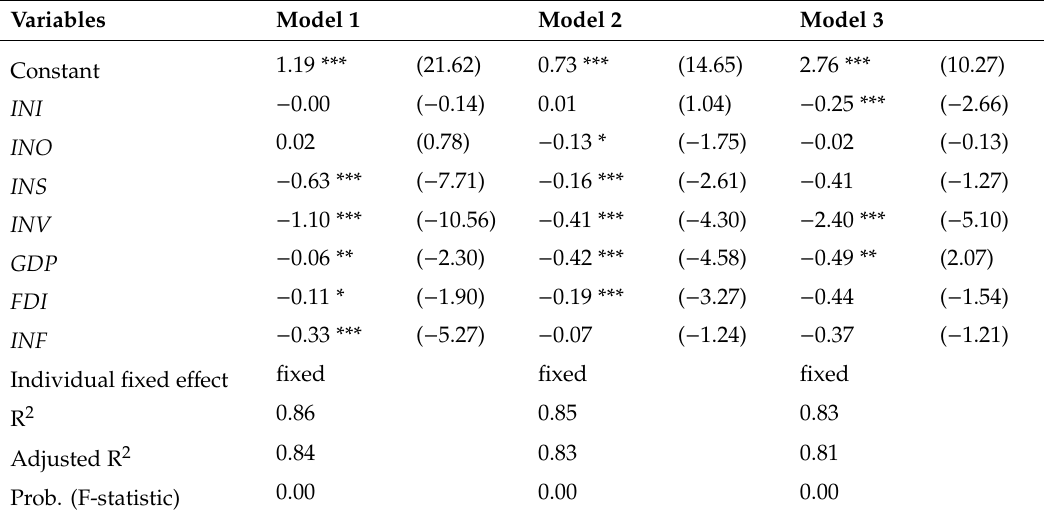
Table 2. Innovation-driven strategy and the impact on green economic development in smart